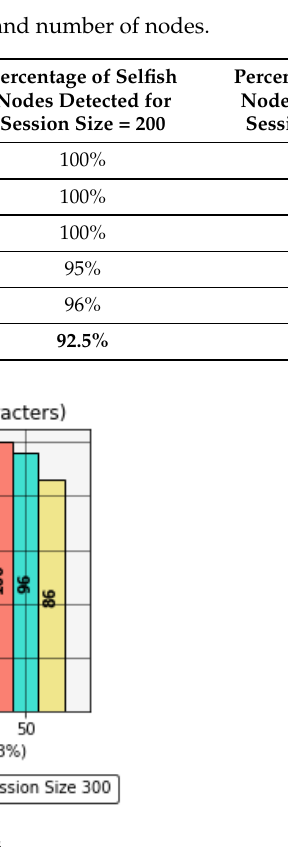
Figure 12. Selfish node detection vs. number of nodes. Table 10. Comparison between blackhole node detection and number of